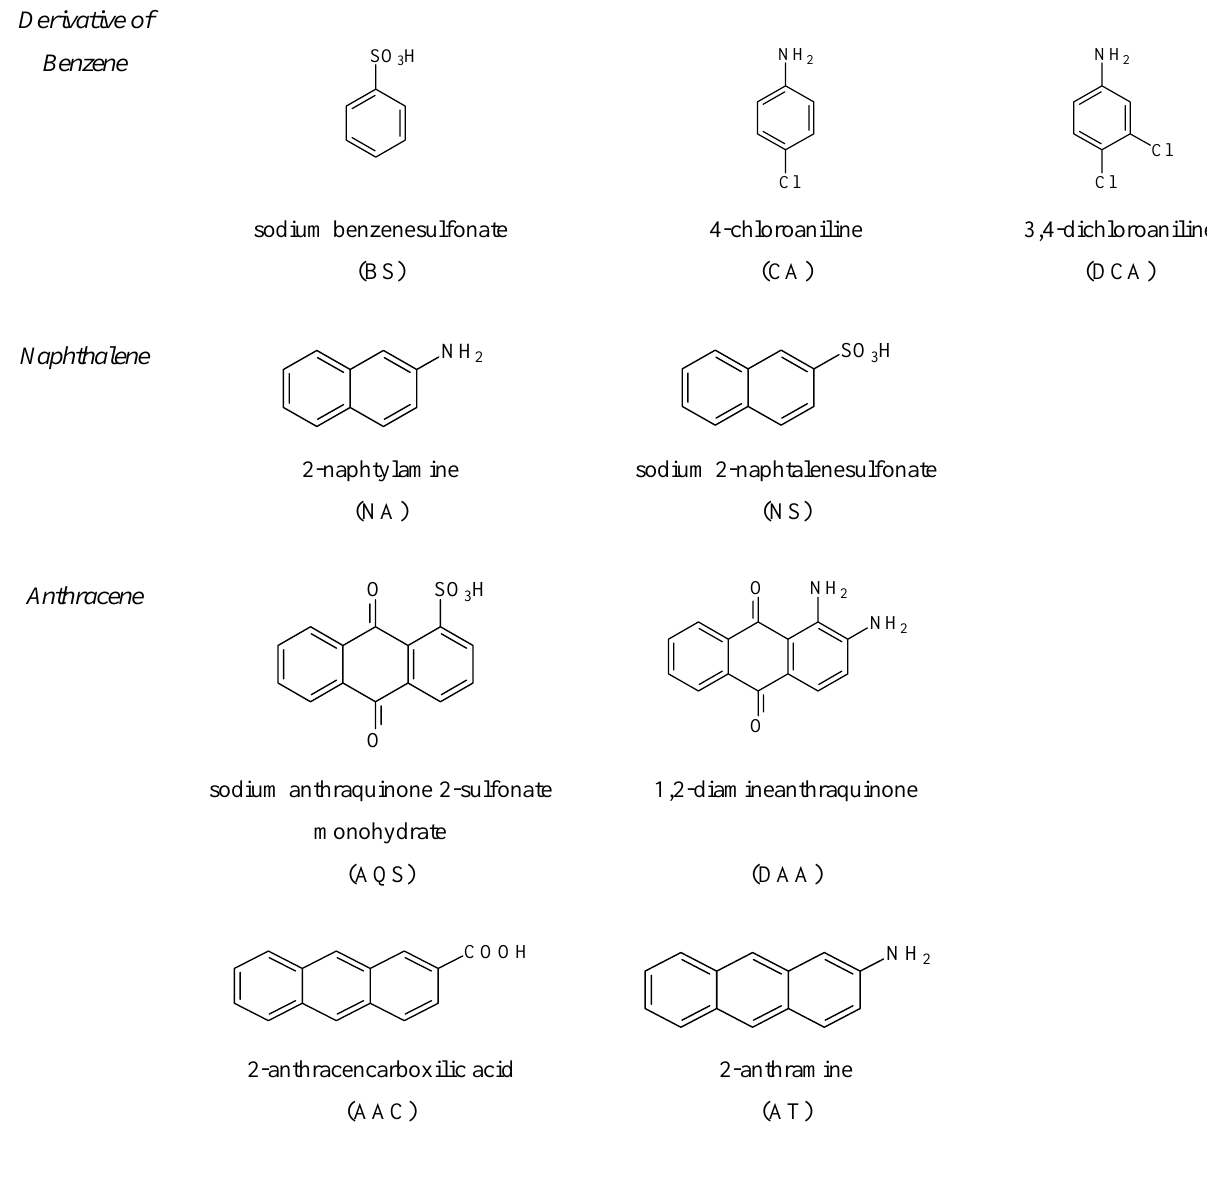
Figure 1. Sketch of the molecules